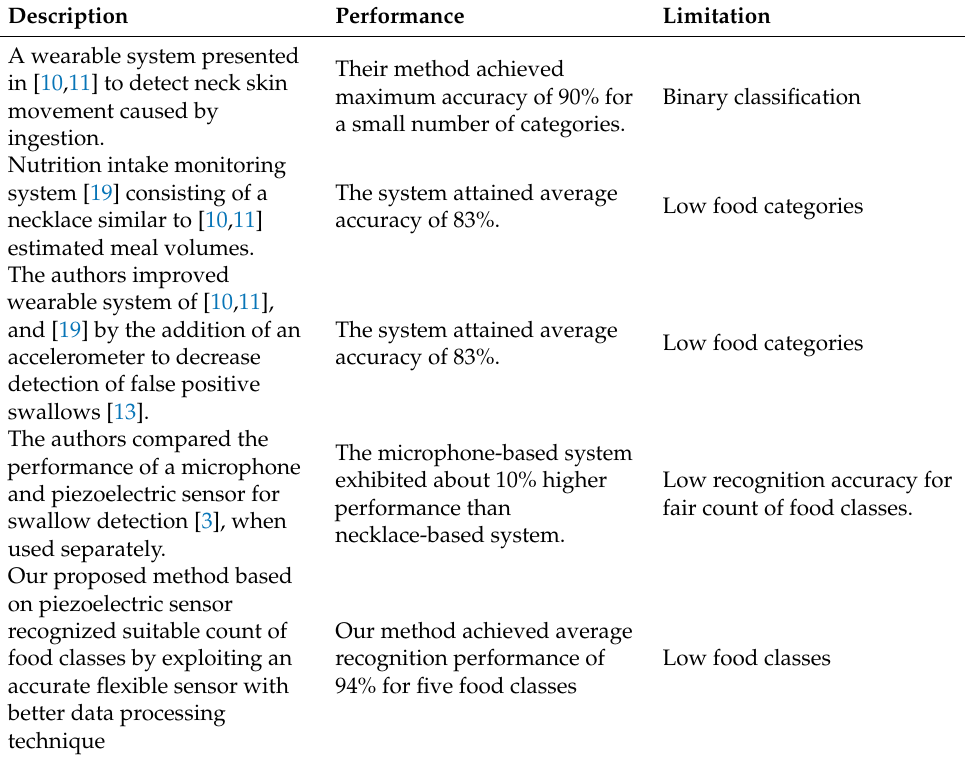
Table 3. The performance comparison between the proposed study and previous related studies. Description Performance Limitation